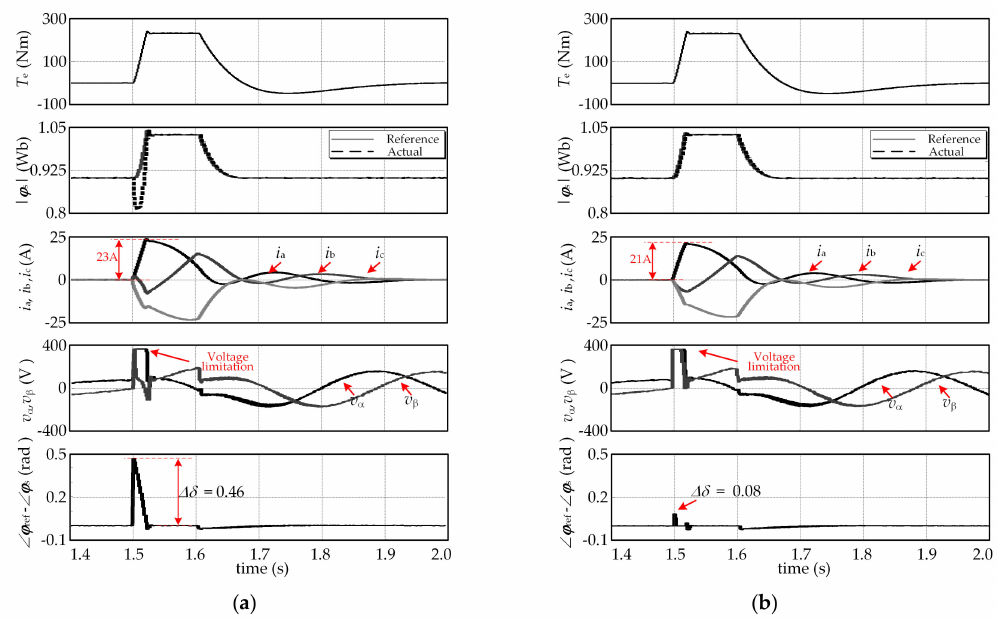
Figure 7. The simulation waveforms for the proposed DTC-SVM Scheme. ( a ) Waveforms with ∆ δ correction; ( b ) waveforms with ∆ δ